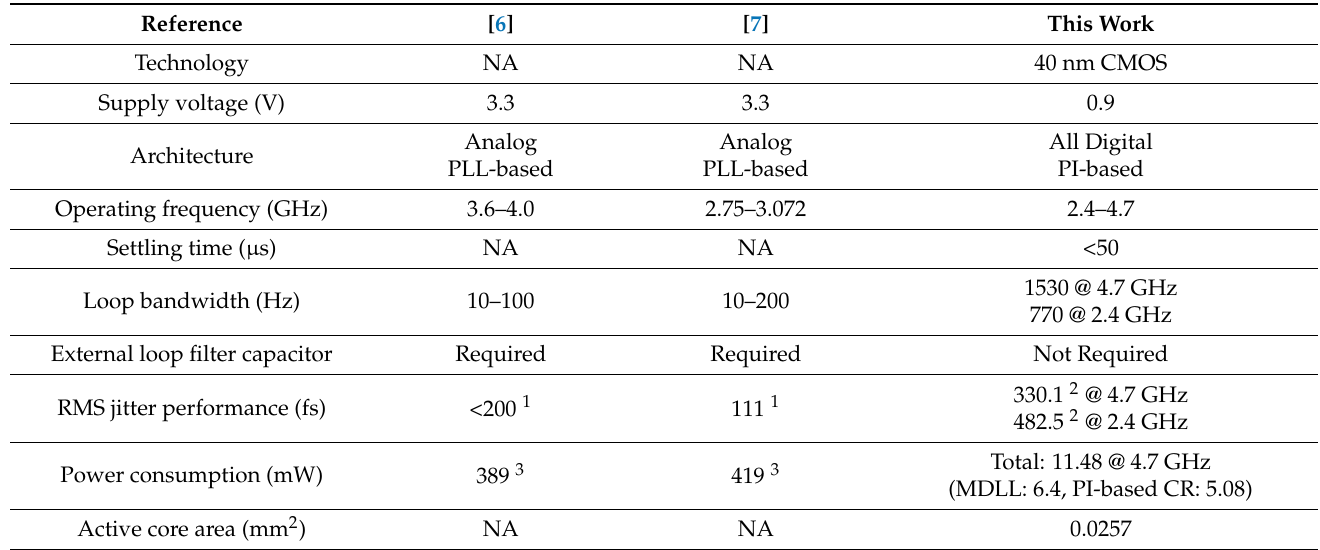
Table 2. Performance table of the proposed all-digital